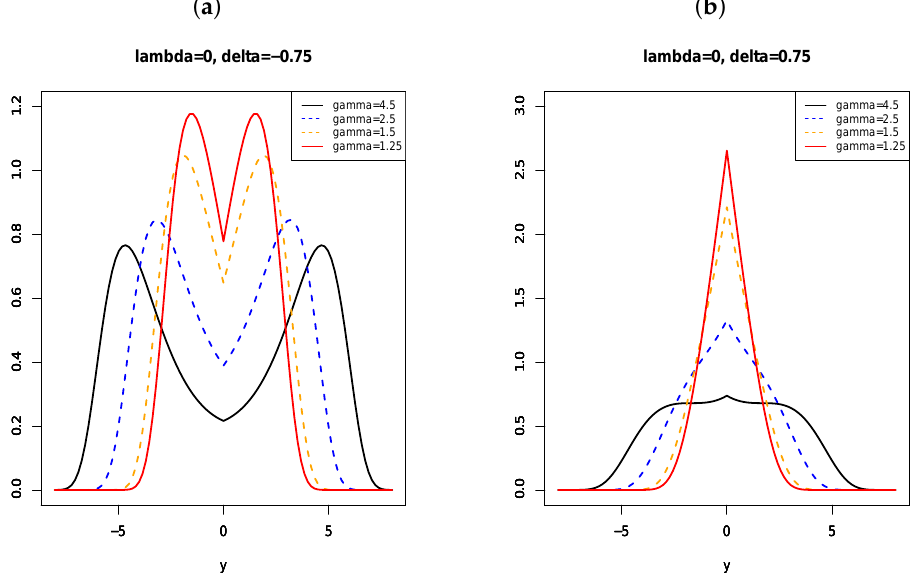
Figure 3. FSHN pdfs: ( a ) FSHN (4.5, 0, 2.5, − 0.75,0) (black), FSHN (2.5, 0, 2.5, − 0.75, 0) (blue), FSHN (1.5, 0, 2.5, − 0.75, 0) (orange) and FSHN (1.25, 0, 2.5, − 0.75, 0) (red); and ( b ) FSHN (4.5, 0, 2.5, 0.75,0) (black), FSHN (2.5, 0, 2.5, 0.75, 0) (blue), FSHN (1.5, 0, 2.5, 0.75, 0) (orange) and FSHN (1.25, 0, 2.5, 0.75, 0)